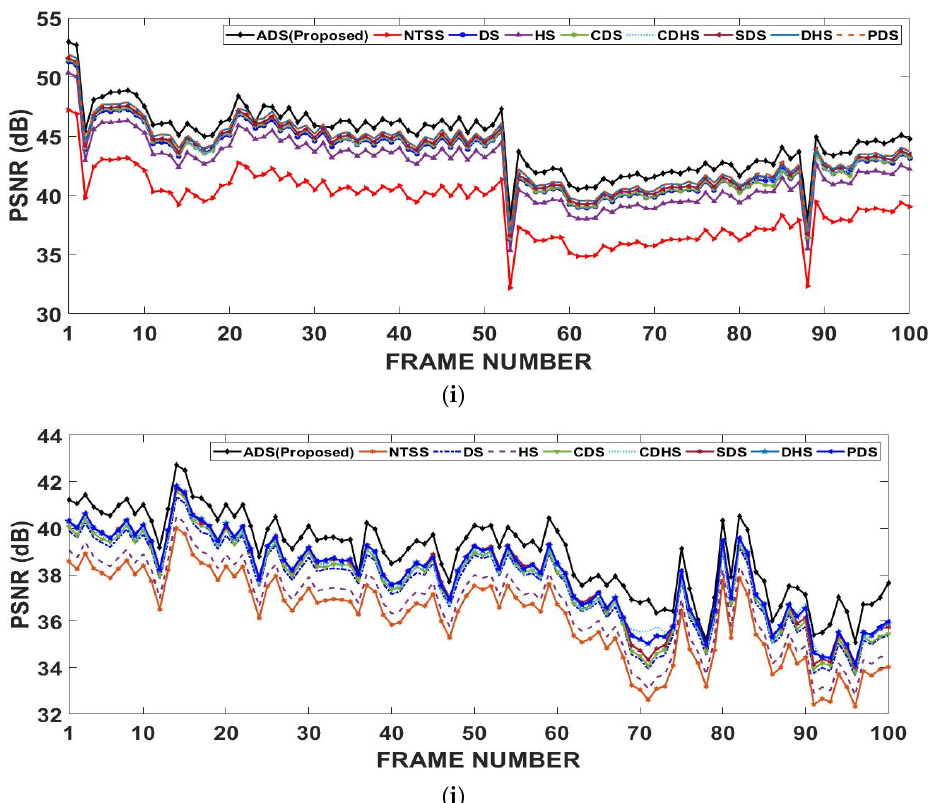
Figure 9. Motion prediction quality comparison of the proposed ADS algorithm and other state-of-the-art and well-known motion estimation algorithms in terms of the peak signal-to-noise ratio (PSNR) for various video sequences: ( a ) Foreman, ( b ) Mobile, ( c ) Rhinos, ( d ) Robot boat, ( e ) Suzie, ( f ) Akiyo, ( g ) Cricket, ( h ) Flower, ( i ) Kari-Jobe, and ( j ) News Flash.